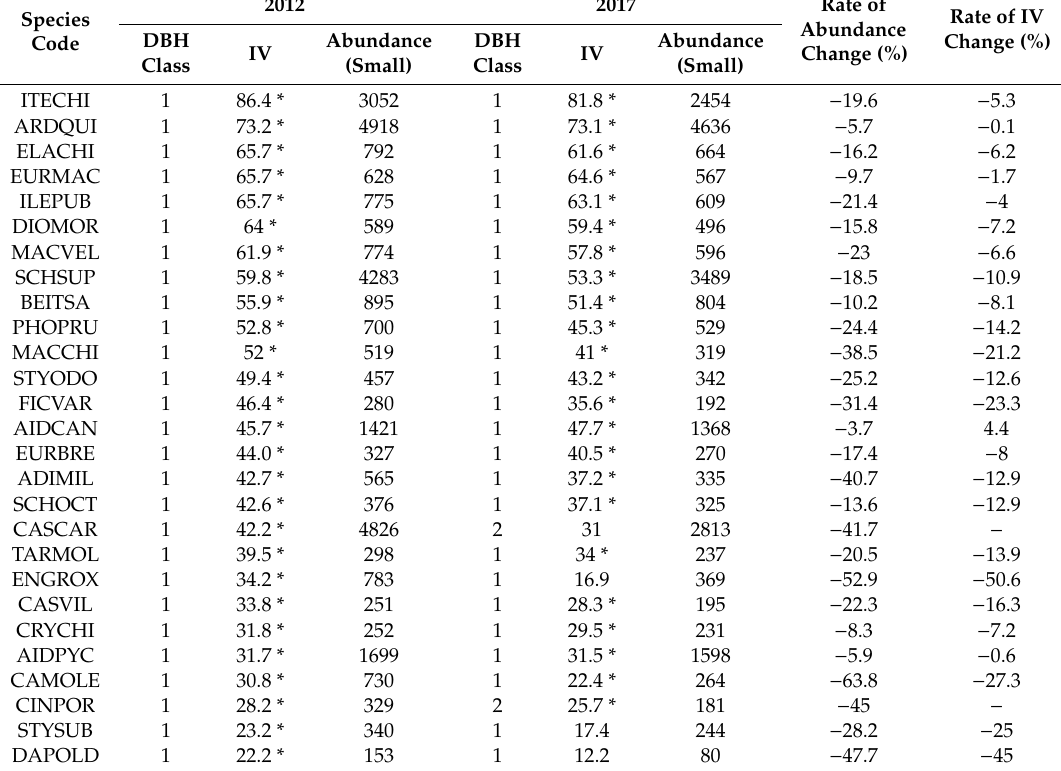
Table 5. Plant species with a significant indicator value (IV) ≥ 20 for di ff erent DBH classes from both 2012 and 2017 communities. The DBH classes are as follows: Small, 1 cm ≤ DBH < 7.5 cm;